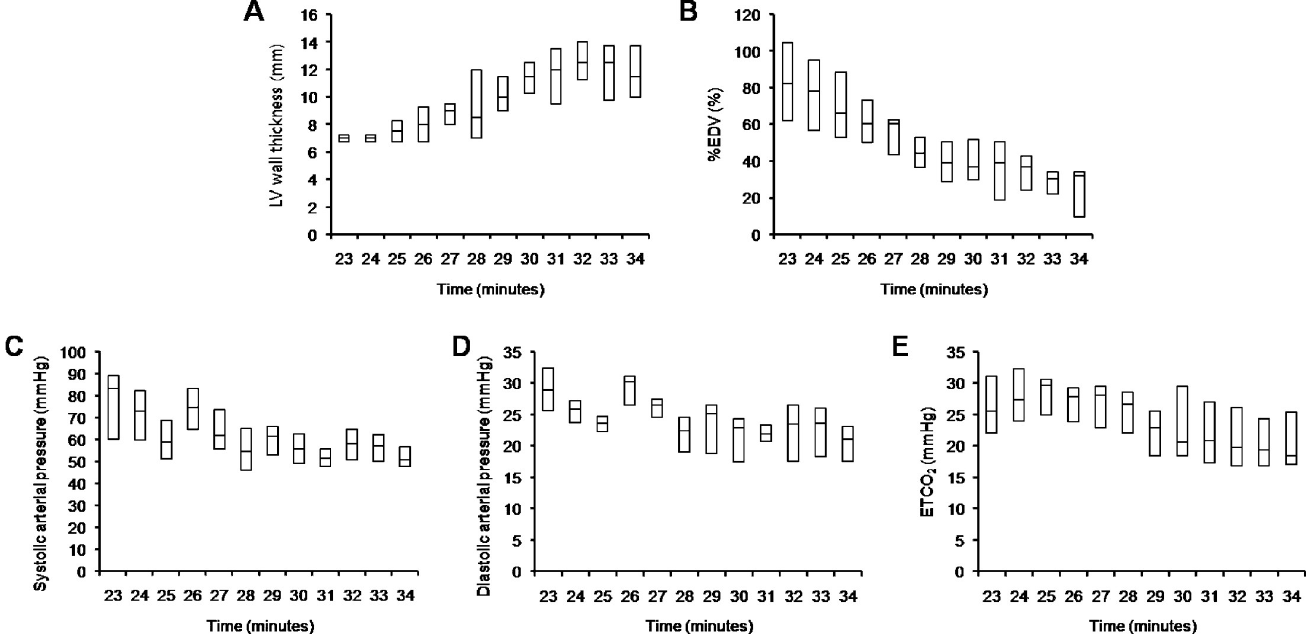
Fig 2. LV wall thickness (A), %EDV (B), systolic arterial pressure (C), diastolic arterial pressure (D), and ETCO 2 level (E) during cardiopulmonary resuscitation. Data are presented as the median and interquartile ranges. LV, left ventricular; EDV, end-diastolic volume; ETCO 2 , end-tidal carbon dioxide.